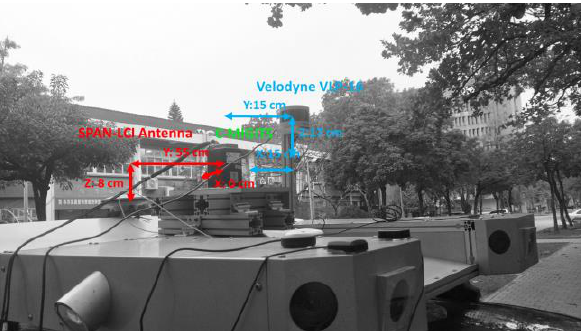
Figure 4. Configuration of the land-based mapping system